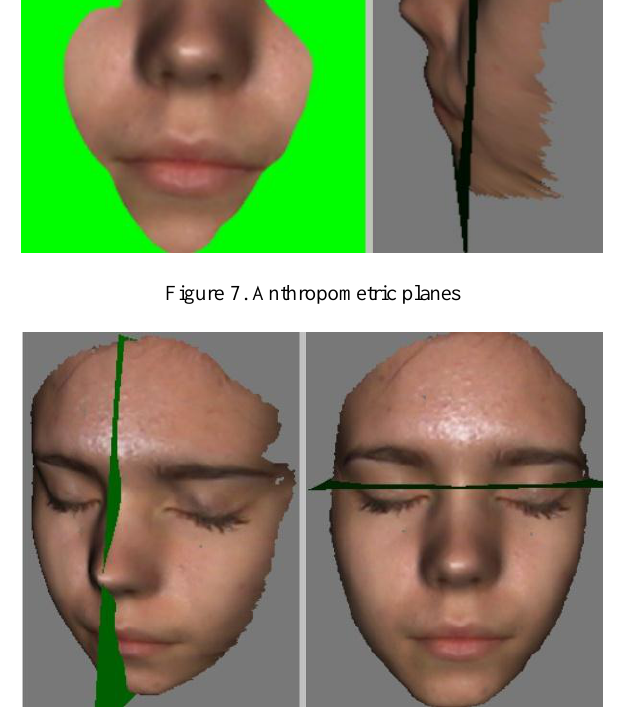
Figure 8. Anthropometric